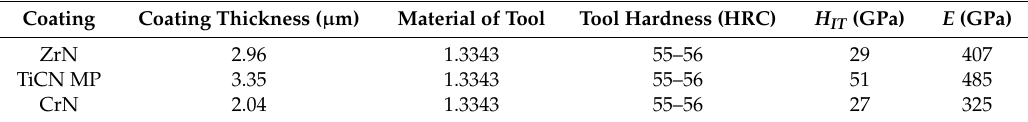
Table 3. Average values of H IT and E of PVD coatings.